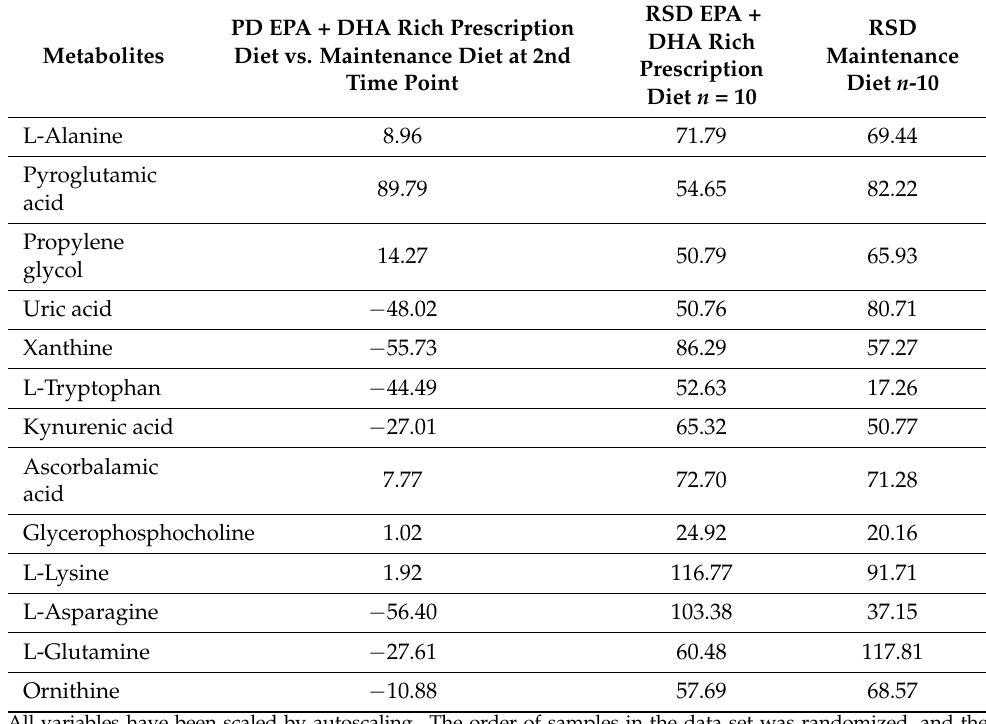
Table 7. List of metabolites at 2nd time point (3 months) selected by VIP model with their percentage difference (PD) and relative standard deviation (RSD).